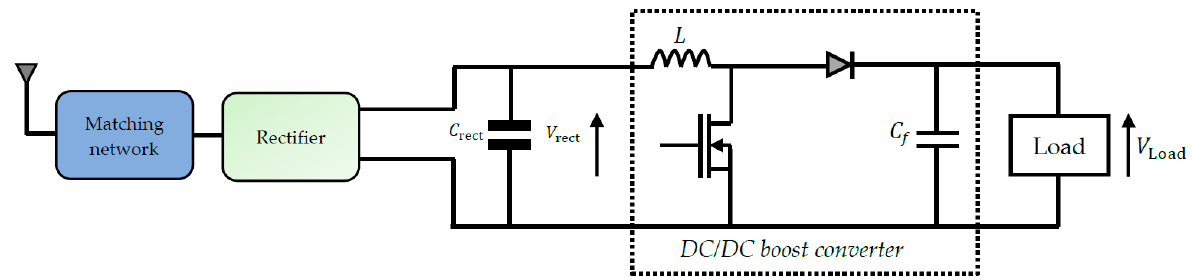
Figure 18. Structure of DC/DC boost